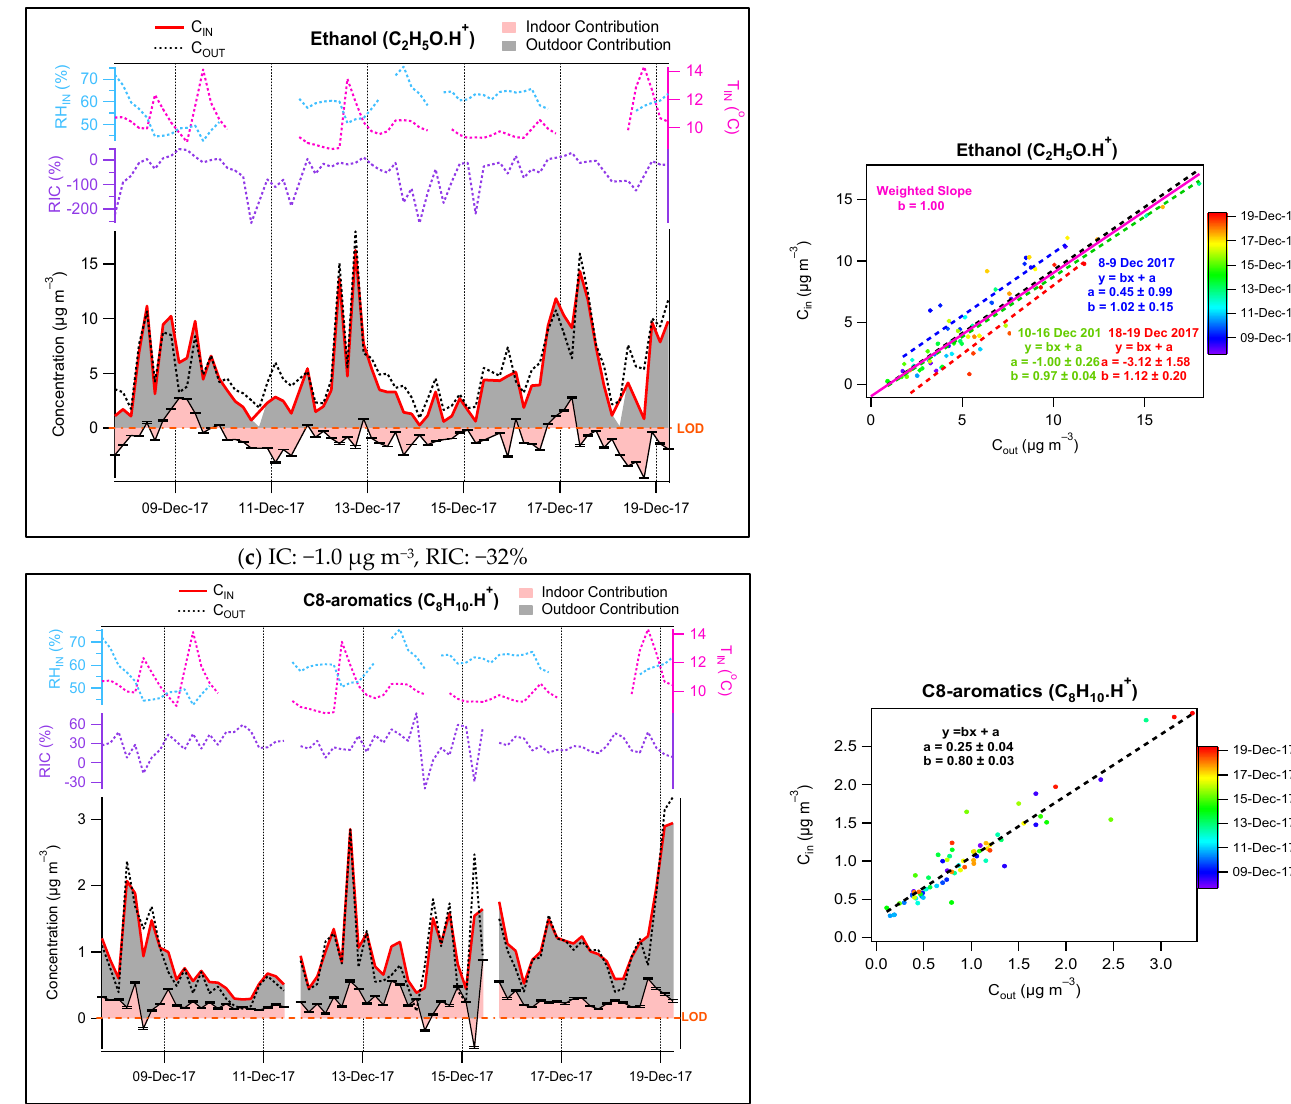
Figure 6. ( a – d ) Examples of IC-OC contributions (left) and scatter plots of indoor-outdoor concentrations (right). Error bars represent 1 σ .